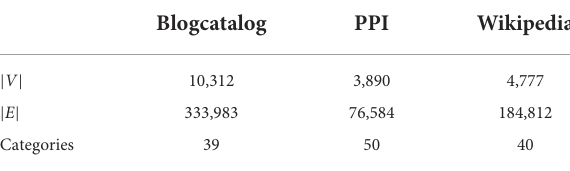
TABLE 1 Graph statistics for the